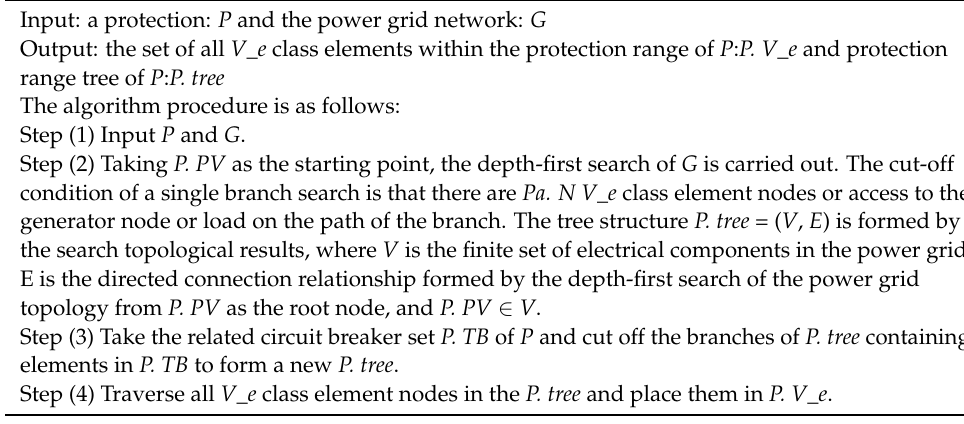
Algorithm 1 Protection range search algorithm: Scope_Protection ( P, G, P. V_e, P. tree )